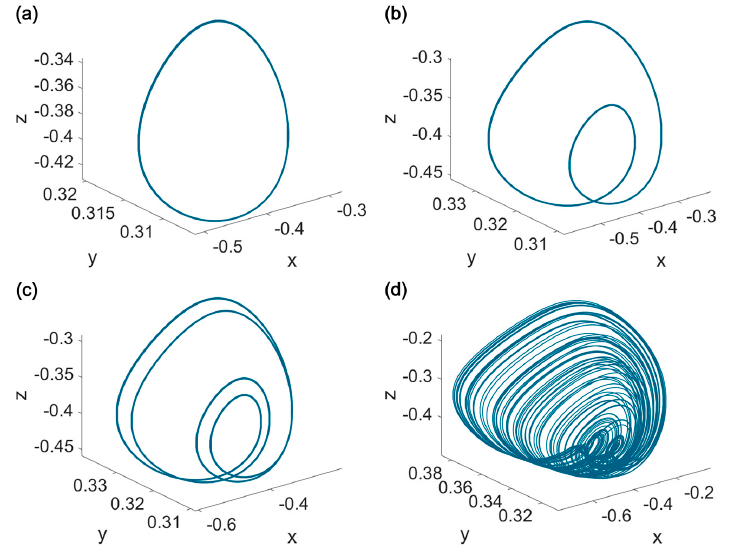
Figure 2. The phase portraits of the FMW neuron for ( a ) α = 0.75 and ( v 0 , r 0 , φ 0 ) = ( 0,1,0 ) , ( b ) α = 0.82 and ( v 0 , r 0 , φ 0 ) = ( 0,1,0 ) , ( c ) α = 0.83 and ( v 0 , r 0 , φ 0 ) = ( 0,1,0 ) , and ( d ) α = 0.95 and (cid:4666)𝑣 (cid:2868) ,𝑟 (cid:2868) ,𝜙 (cid:2868) (cid:4667) = (cid:4666)0,−1,0(cid:4667) . Other parameters are 𝐶 (cid:3040) = 1 , 𝐸 (cid:3015)(cid:3028) = 0.95 , 𝐸 (cid:3012) = −0.95 , 𝑔 (cid:3012) = 26 , 𝑡 (cid:3045) = 5 , t φ = 0.5, a = 1, b = 3, k = 8.5, and ε = 1.